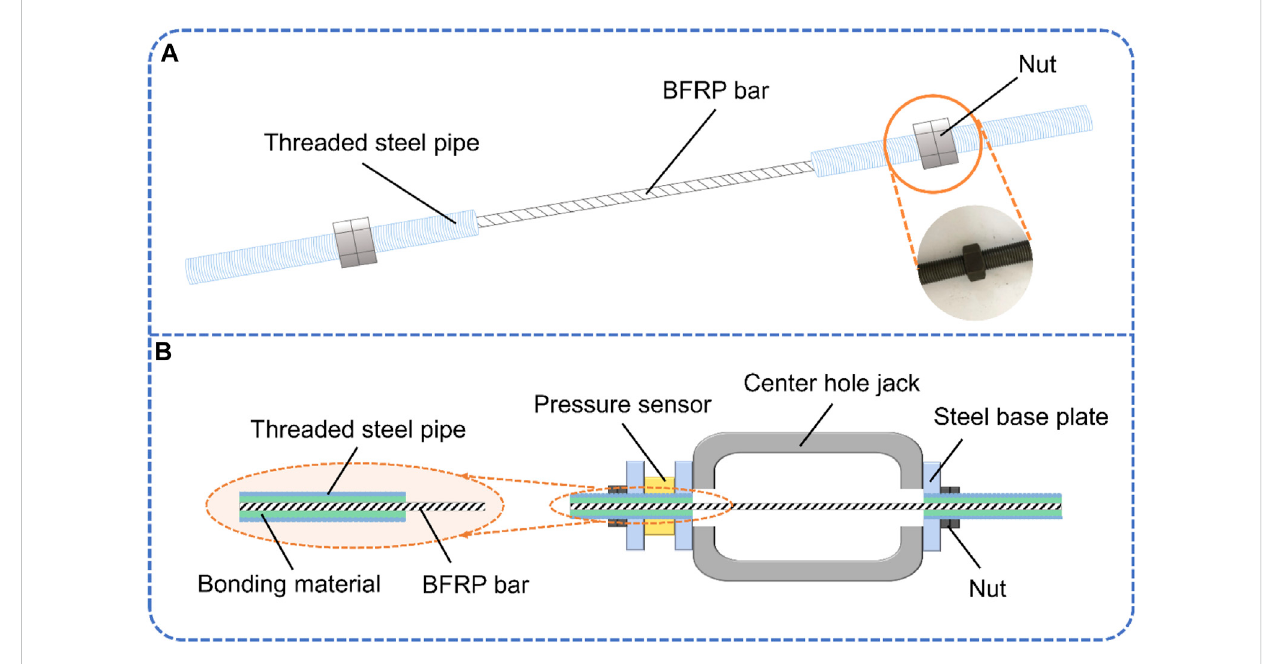
FIGURE 4 Structure of the TSAS and the corresponding tension device: (A) Structure of the TSAS, (B) Tension device of the TSAS.